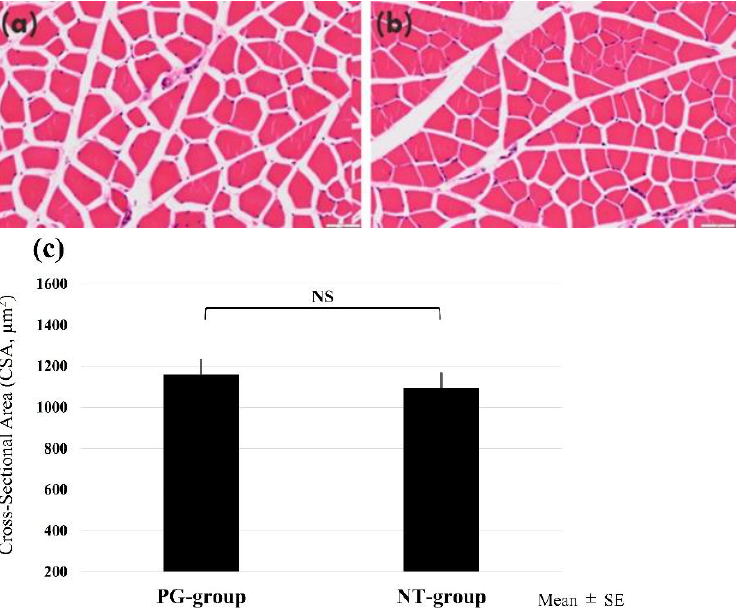
Figure 3. Histology of the myotubes: ( a ) PG group; ( b ) NT group; ( c ) average CSA of both groups. There were no significant differences between the groups.